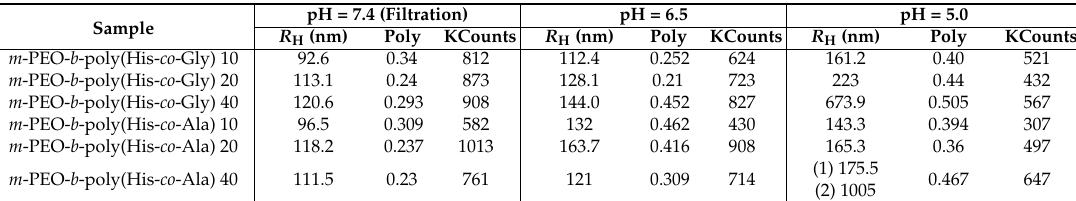
Table 2. DLS results for the synthesized polymers at 25 ◦ C and 90 ◦ .